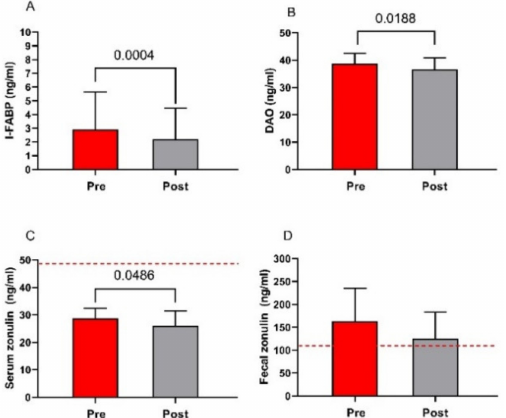
Figure 6. Biomarkers of intestinal barrier function and integrity before and after low FODMAPs diet. Panel ( A ) intestinal fatty acid-binding protein—I-FABP; panel ( B ) diamine oxidase—DAO; panel ( C ) serum zonulin; and panel ( D ) fecal zonulin. Data are presented as mean ± SD. Statistical analysis: Wilcoxon matched-pairs signed-rank test with a significant difference set at p < 0.05. The cutoff value is indicated by the red dashed line.